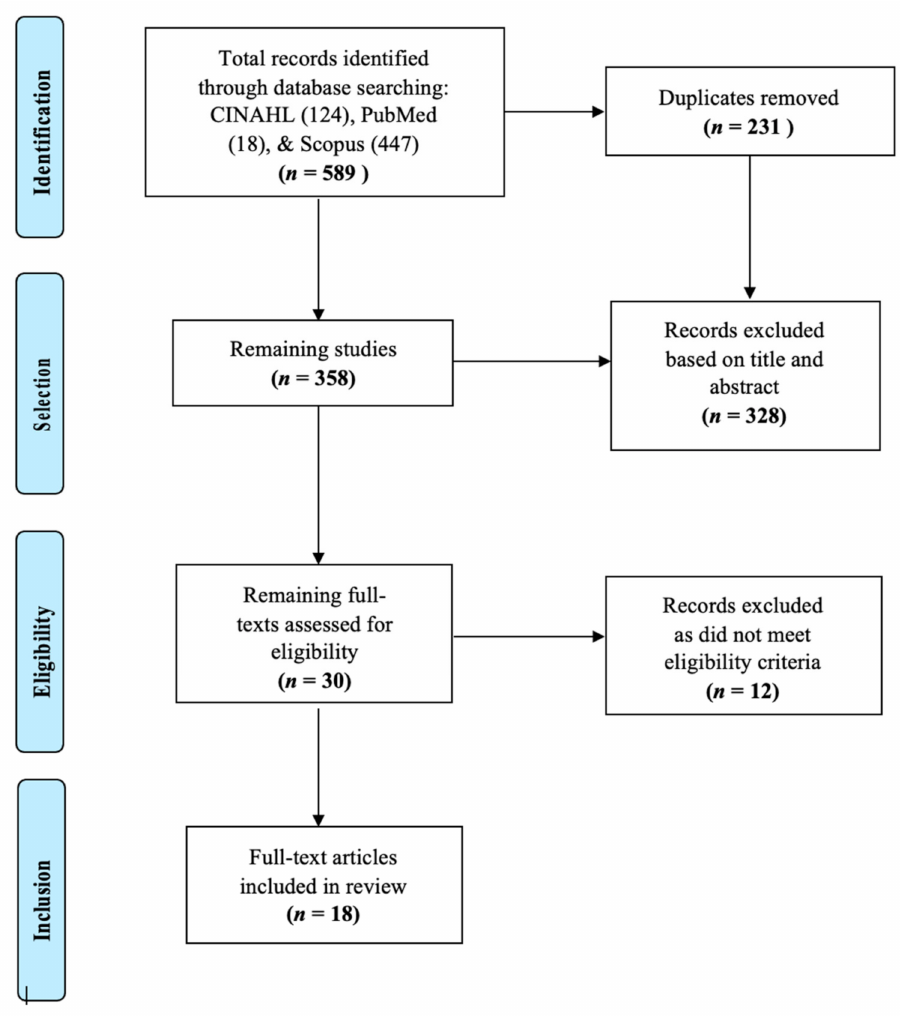
Figure 1. Flow diagram of search history and resulting